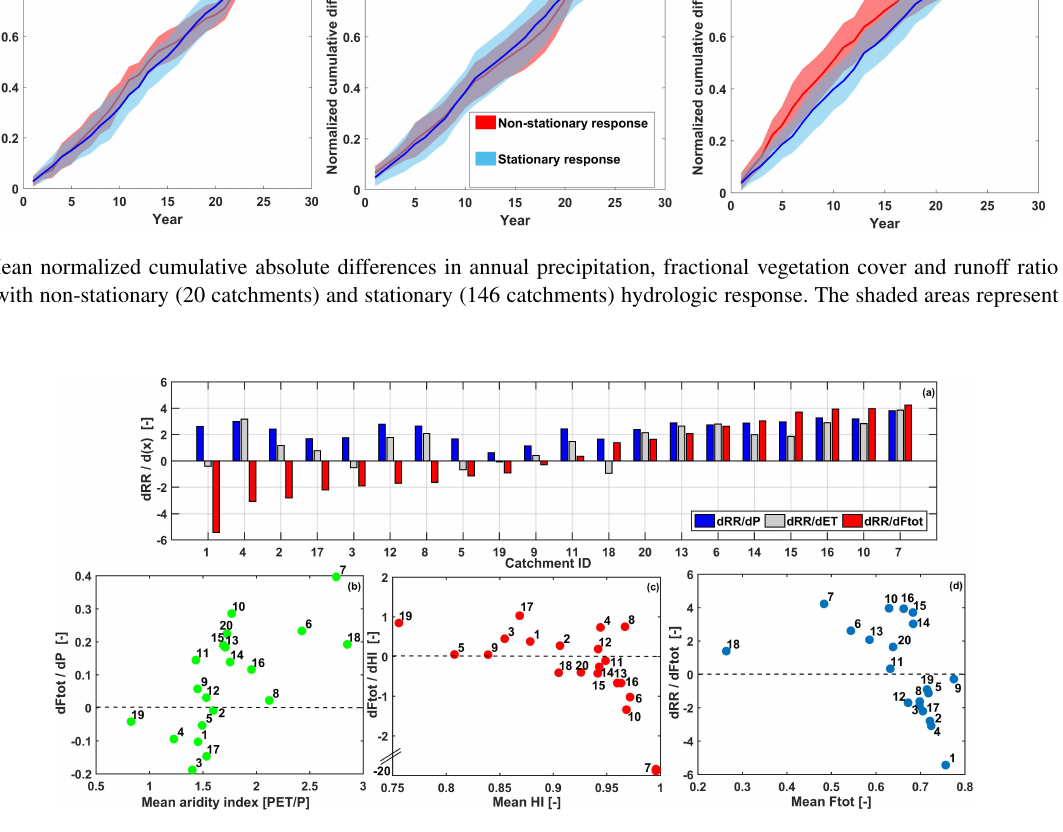
Figure 4. (a) Normalized sensitivities of runoff ratio (RR) to precipitation ( P ), water balance ET and fractional vegetation cover ( F tot ); nor- malized sensitivities of annual (b) fractional vegetation cover to precipitation against catchments’ mean aridity index, (c) fractional vegetation cover to the Horton index (HI) against catchments’ mean Horton index and (d) runoff ratio to fractional vegetation cover against catchments’ mean fractional vegetation cover in catchments with non-stationary hydrologic response. Data labels refer to the station identification number in Table